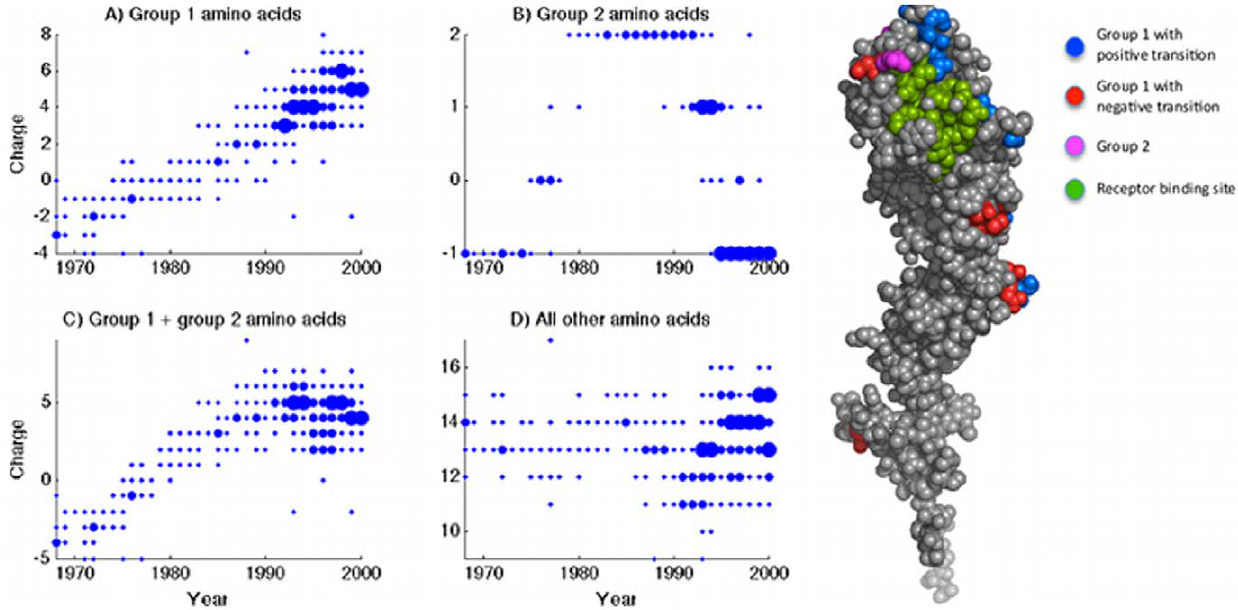
Figure 4. Charge trends when summed separately over ‘group 1’ and ‘group 2’ amino acids (see table 1). This approach shows that certain sites, which reverted charge state between 1985 and 2000, may account for the ‘plateau’ in total HA charge observed over this time. The right- hand panel locates the amino acids on the HA structure, showing the receptor binding site in green; group 1 positions showing a positive transition (in blue); group 1 positions showing a negative transition (in red); and group 2 positions, showing a transition followed by a reversion in a subsequent year (in magenta).